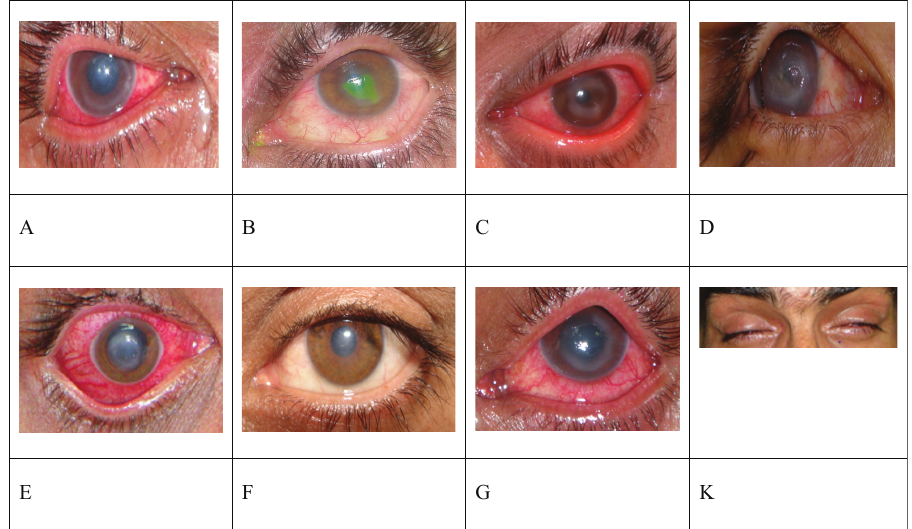
Figure 2. Slit photos in some patients. (A) Ring infiltration and diffuse patchy stromal infiltration; (B) Ring infiltration, diffuse patchy stromal infiltration, and PED (persistent epithelial defect); (C) Ring infiltration; (D) Seventh cranial nerve palsy, PED, diffuse stromal infiltration, and ring infiltration; (E) Central dense stromal infiltration; (F) Corneal scar and stromal haze following treatment of stromal infiltration; (G) Ring infiltration and stromal haziness; (K) Severe